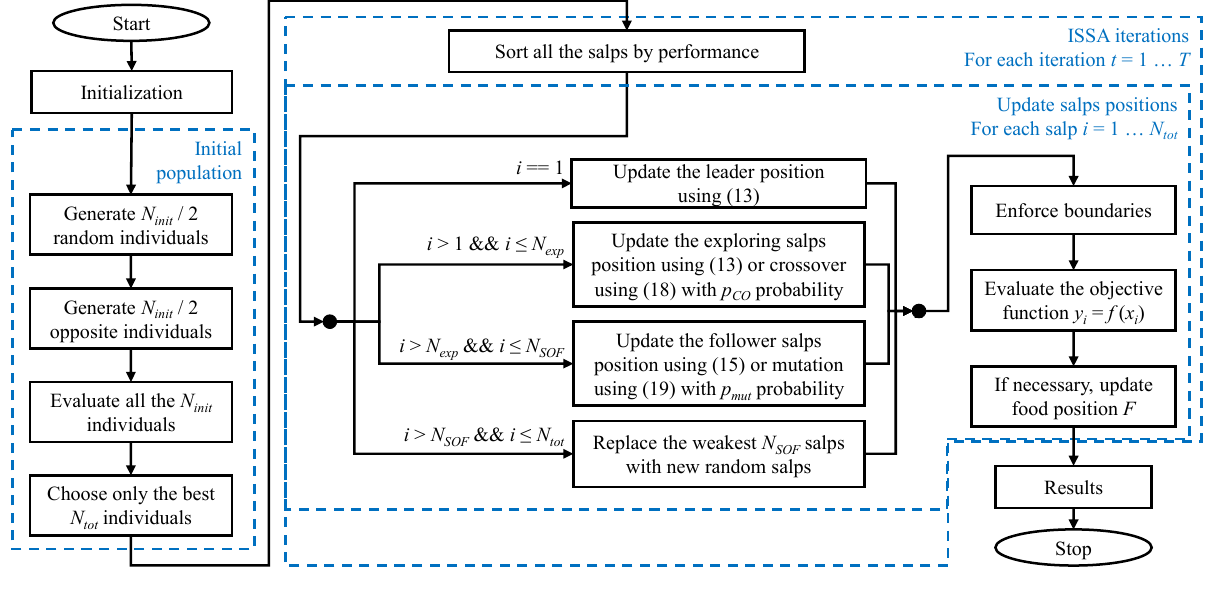
Figure 1. Flowchart of ISSA methodology.